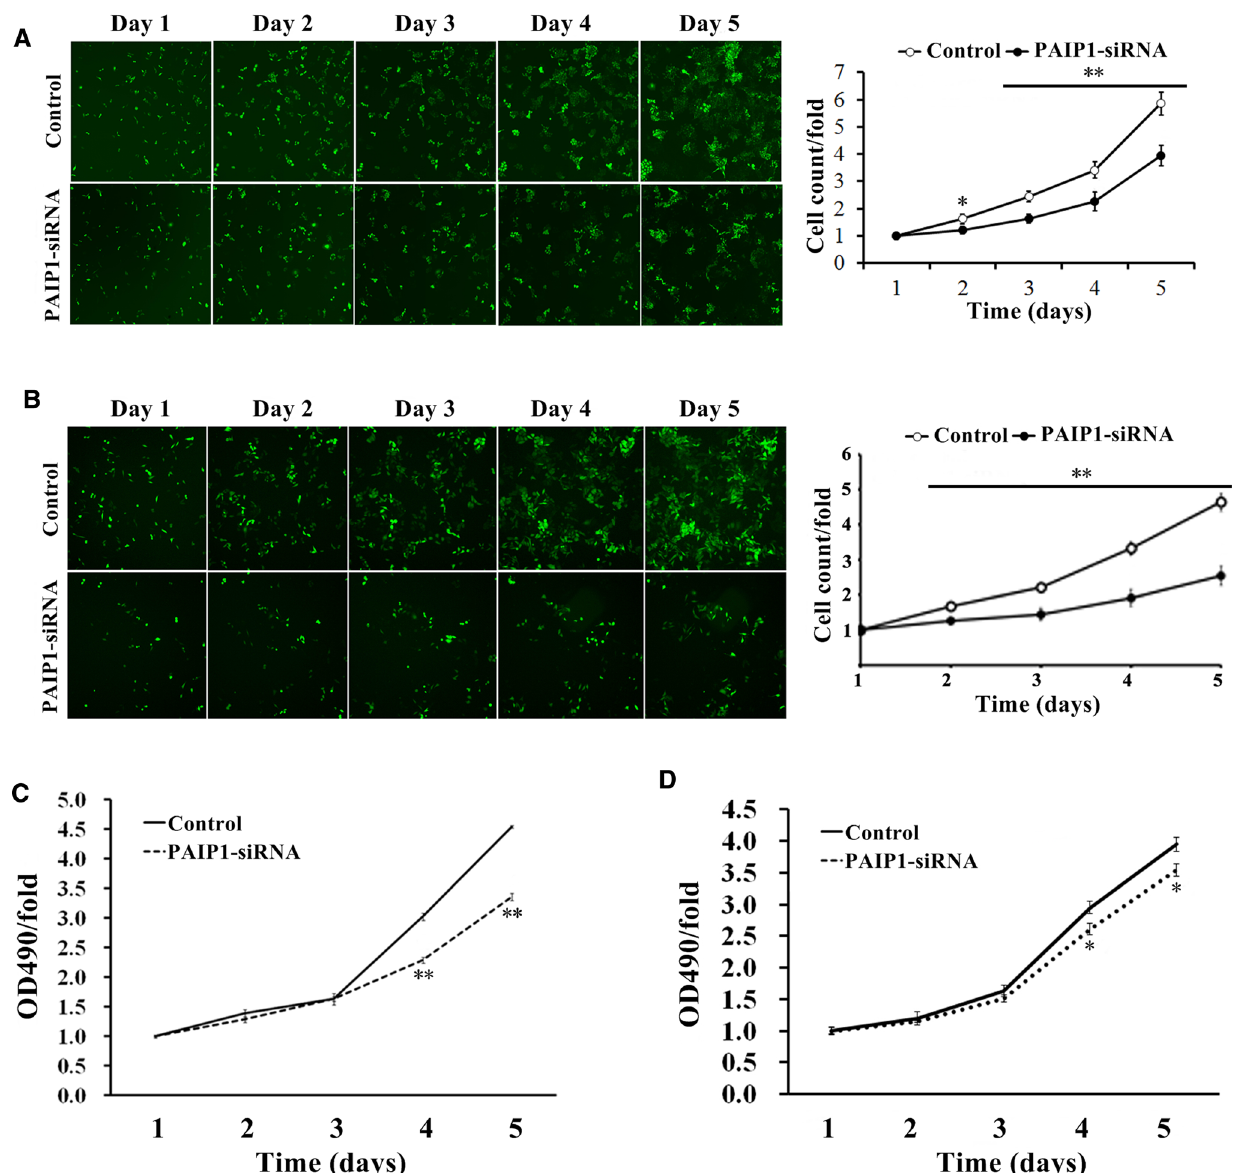
Fig.2 Effect of PAIP1 Knockdown on HCC Cell Proliferation . A , B Cellomics experiments for A SMMC-7721 cell proliferation and B HEPG2 cell proliferation. Representative images of green fluorescence protein (GFP)-expressing cells over time (left panels, image magnification: 10 ×). Proliferation curves (right panels) were constructed based on GFP expression. The cell count/fold represents the fold-change of the cell count for each respective day normalized to the original cell count on day one. C , D MTT experiments for C SMMC-7721 cell proliferation and D HEPG2 cell proliferation. OD490/fold represents the fold-change of the OD490 value for each respective day normalized to the origi- nal OD490 value on day one. Results are displayed as means and standard deviations (SDs) from three independent experiments. * P < 0.05, ** P < 0.01